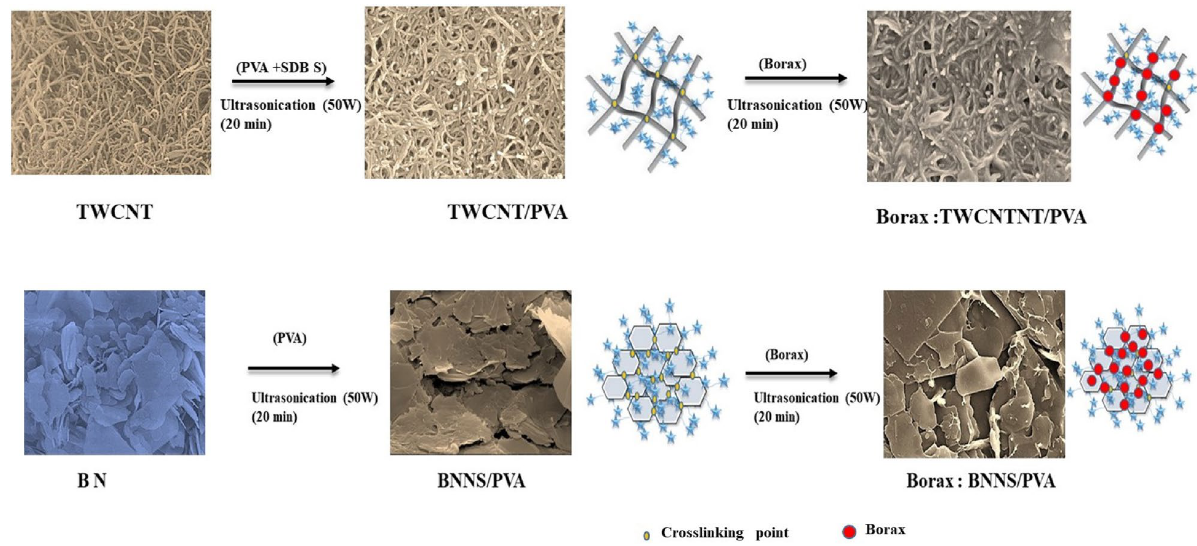
Figure 7. Enhancement mechanism through reinforced crosslinking and formation of thermal transport network by adding